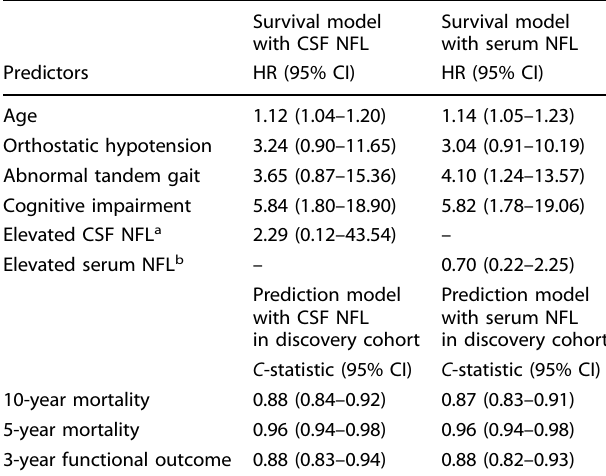
Table 4. Predictors of mortality in Parkinson ’ s disease subgroup. Table 5. Prediction chart of unfavorable outcome in patients with uncertain